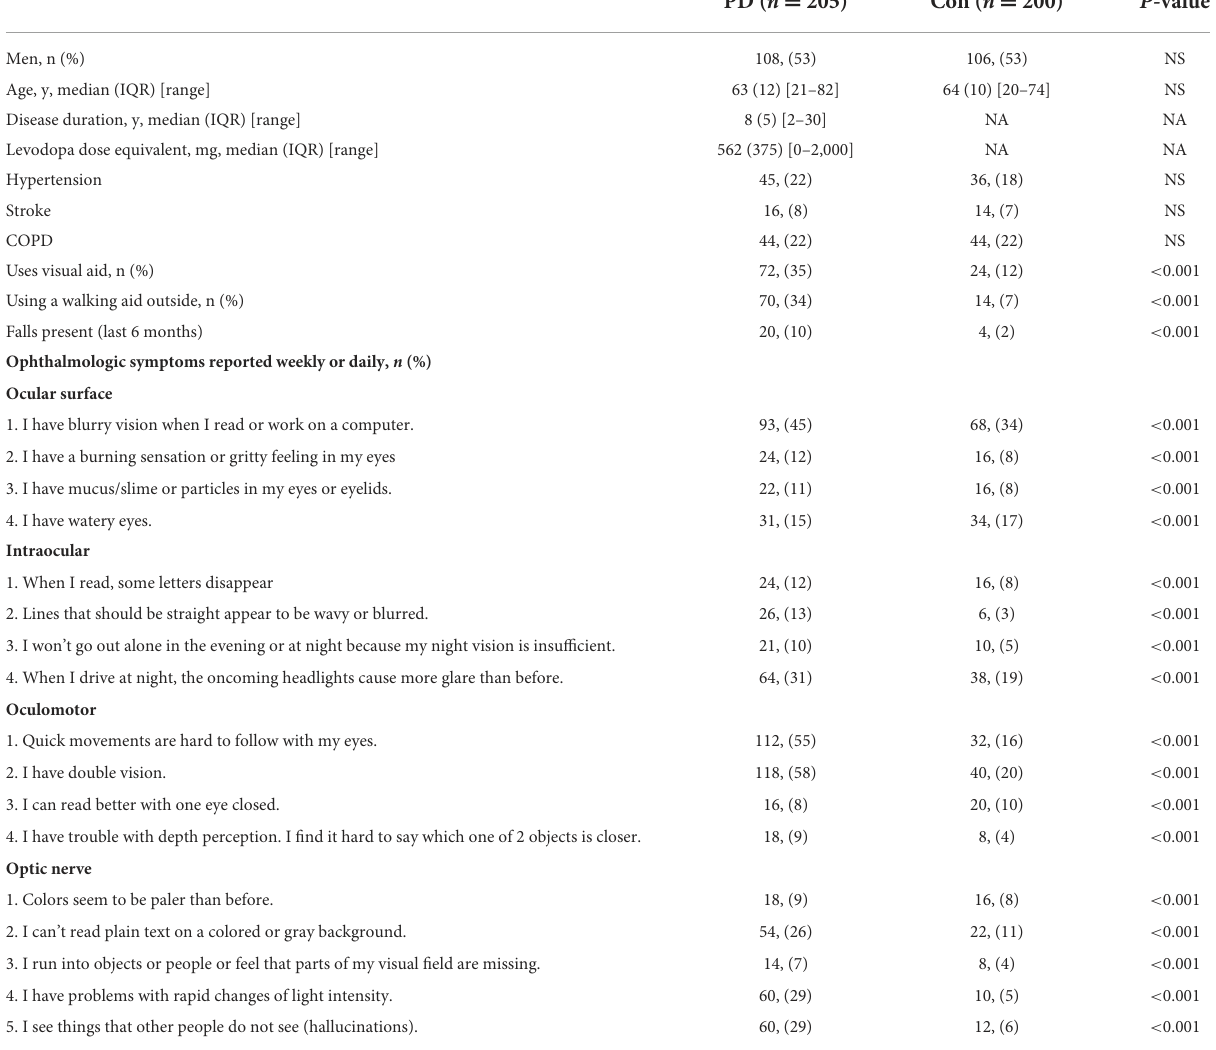
TABLE 1 Participant characteristics and Prevalence of ophthalmologic